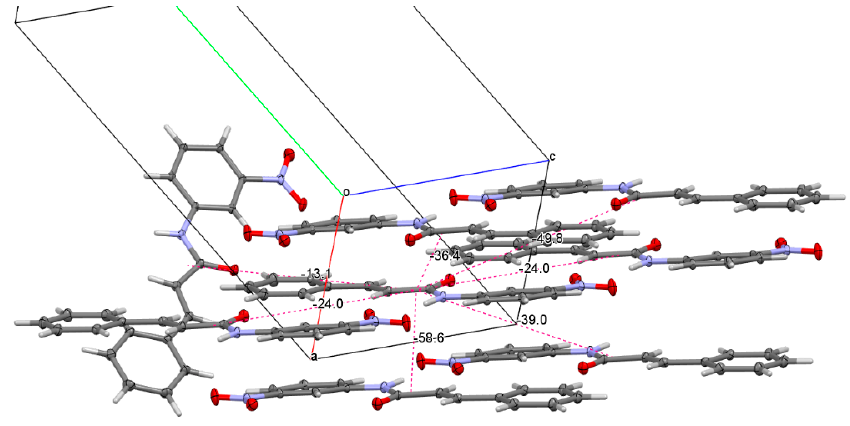
Figure 9. Intermolecular potential energies obtained by UNI forcefield calculations.